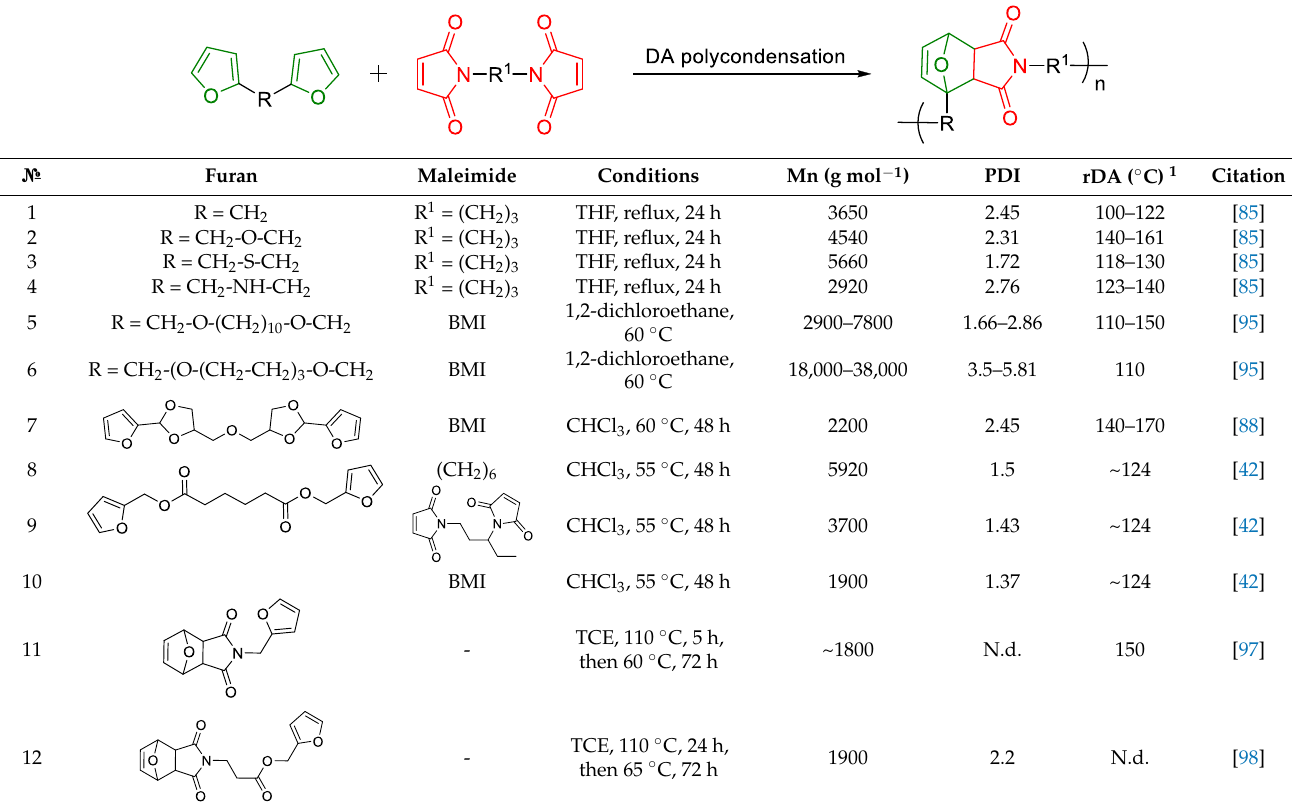
Table 4. Synthesis of linear polymers using the fmDA polycondensation.